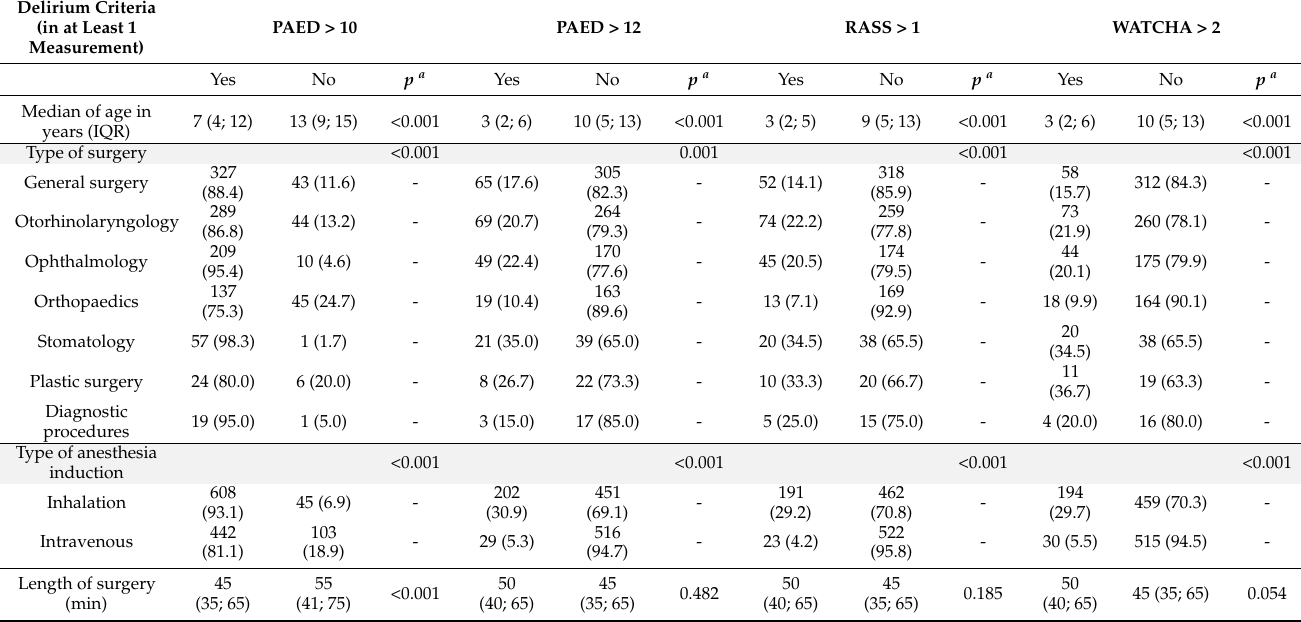
Table 3. Incidence of ED according to the PAED, Watcha and RASS score compared with demo- graphic variables.